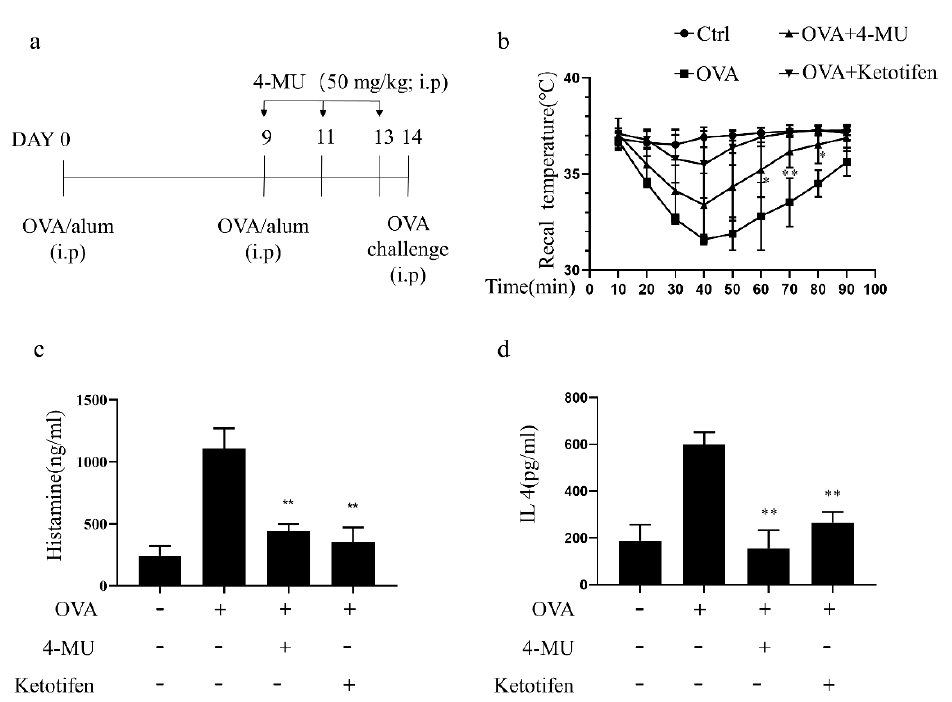
Figure 6. 4-MU attenuates allergic reactions in ASA mice. ( a ) ASA protocol (ketotifen, positive control). ( b ) Mean (± SD) rectal temperatures taken every 10 min after initiation of an OVA challenge (three independent experiments). ( c ) Effects of 4-MU on histamine release into serum (determined by ELISA). ( d ) Effects of 4-MU on serum IL-4 levels in ASA mice (determined by ELISA). Means ± SDs (three independent experiments) are shown (N = 5/group); * p < 0.05, ** p < 0.01 vs. activated group not pretreated with 4-MU.